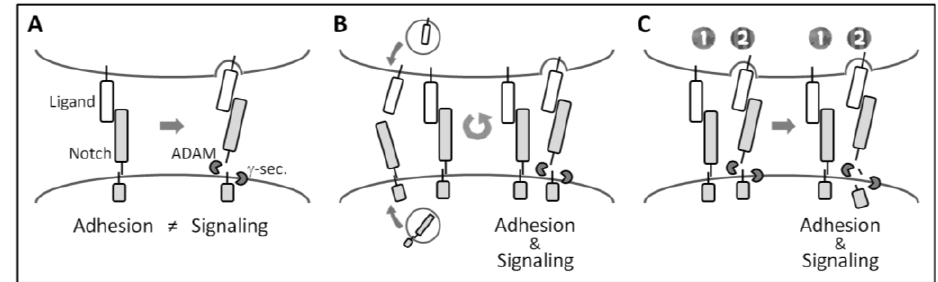
Figure 4. Possible explanations for long-lasting Notch-mediated cell adhesion accompanied by Notch signaling activation in mammals. ( A ) Although adhesion and signaling functions are traditionally considered to be incompatible, our findings suggest that they are compatible; ( B ) the turnover hypothesis. The function of adhesion is transient, consistent with the traditional view. However, newly-formed Notch and DSL ligands successively form Notch receptor-ligand interactions, and, thus, cells appear to stably adhere to each other; and ( C ) the dissociation-resistant interaction hypothesis. There are two forms of Notch receptor-ligand interactions, i.e. , dissociation-resistant (1) and dissociation-sensitive (2). The former assumes long-lasting cell adhesion, while the latter assumes signaling